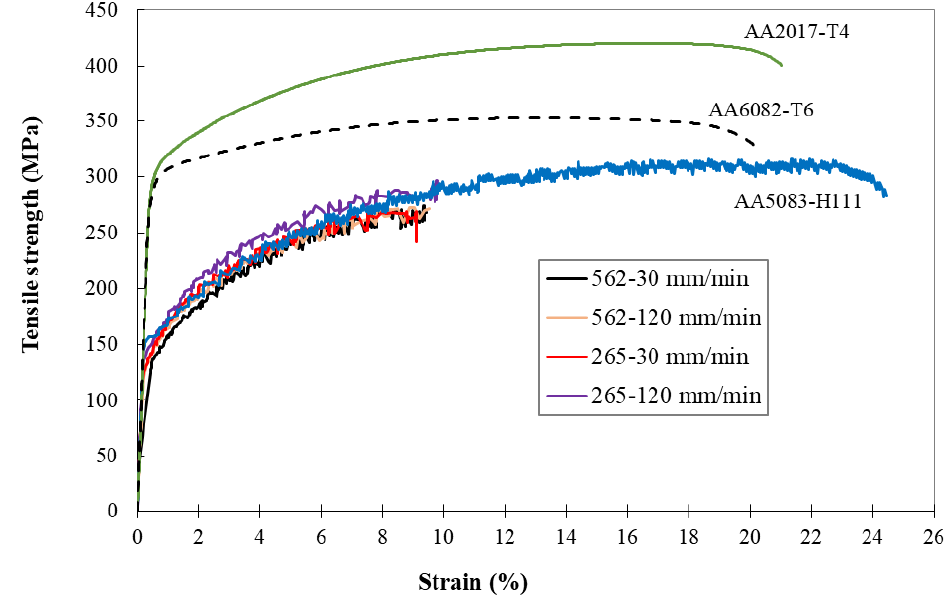
Figure 12. Tensile stress–strain curves of the 562 and 265 weld series and the base materials. Table 5. Average tensile results of defect-free welded specimens.